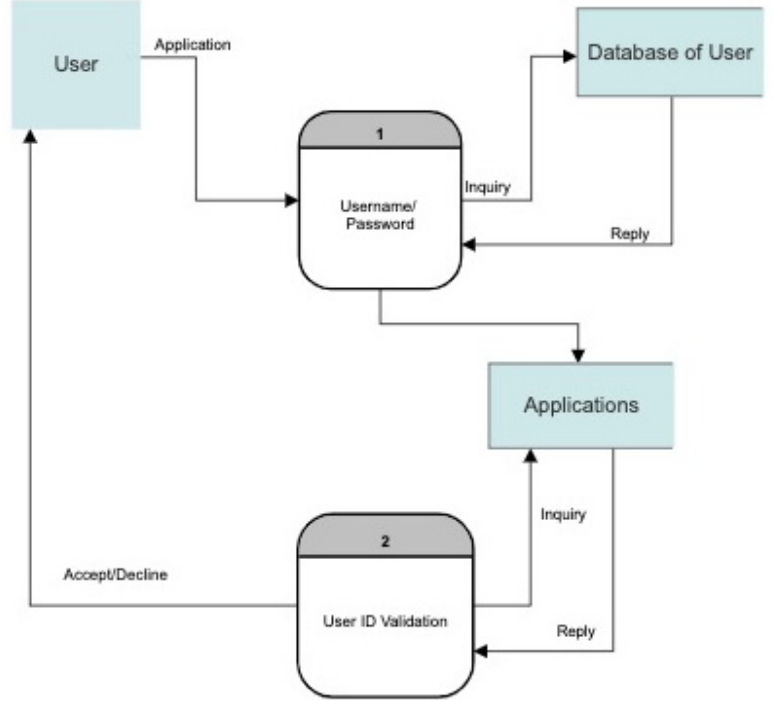
Figure 5. Data Flow Diagram of User Registration.